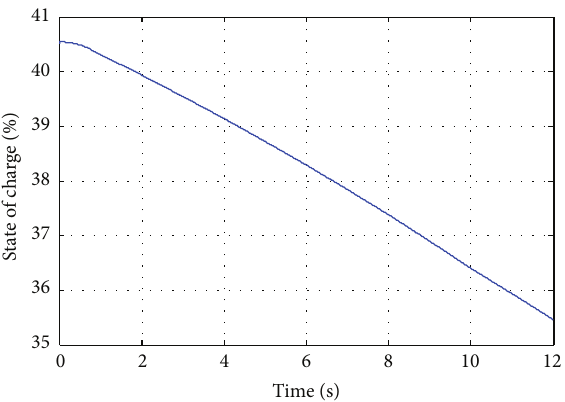
Figure 12: Evolution of the SOC in the different phases.